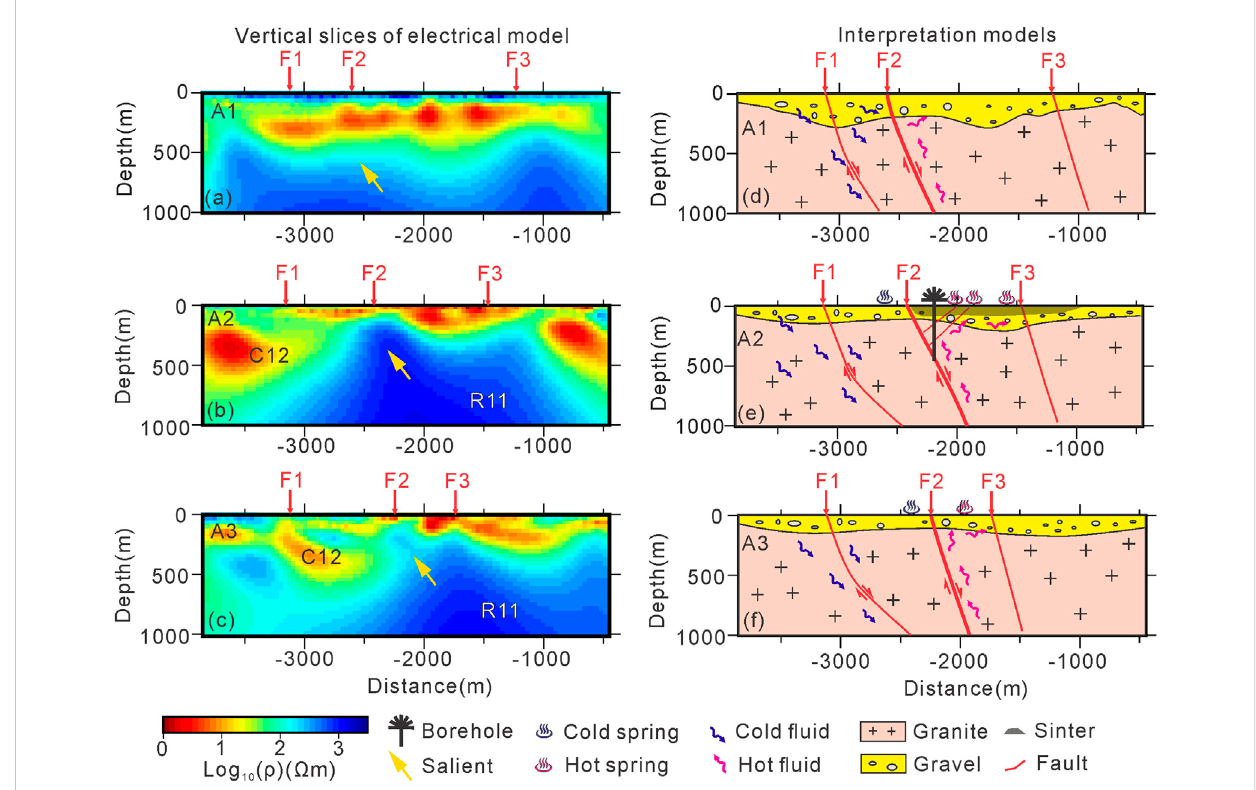
FIGURE 4 VerticalslicesofelectricalmodelandinterpretationrevealedbyAMT. (A – C) SectionresistivitymodelsofA1-A3.Highresistivitysalientisanimportant featureintheelectricalmodel,asshownbyyellowarrows. (D – F) InterpretationmodelsofA1-A3.FaultsF1andF2maybethecoldandhot fl uidsmigration channel, respectively. The resistor R11 may imply presence of